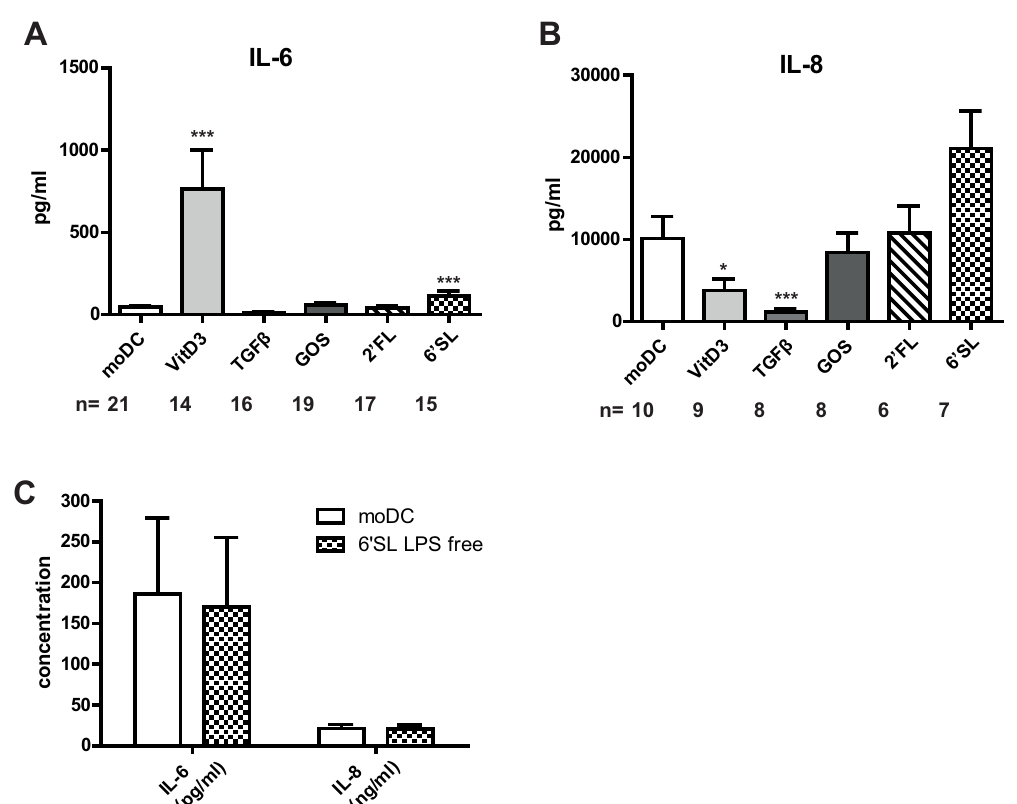
Fig 2. TGF β and VitD3 differentially modulate the production of IL-6 and IL-8 during differentiation. 6’SL was treated with an optimized Triton X-114 method to remove LPS traces. Immature DC were cultured for six days in the presence or absence of VitD3, TGF β ,6’SL, LPS-free 6’SL, 2’FL or GOS. A,C) IL-6 and B,C) IL-8 were measured in the supernatant by CBA.